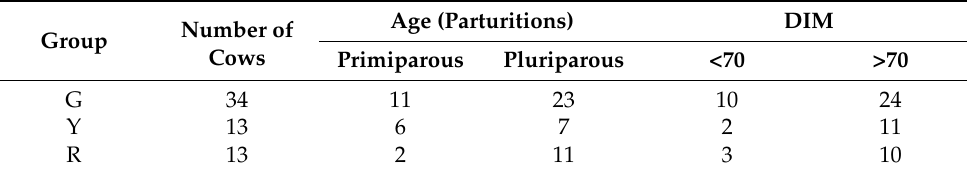
Table 1. Partitioning of lactating cows in healthy (G), at risk (Y) and with mastitis (R) on the basis of total somatic cell count (SCC) and differential somatic cell count (DSCC).